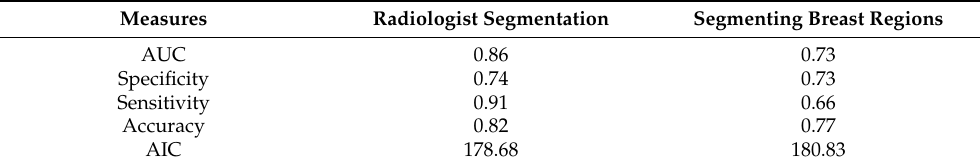
Table 5. Comparison between models with CS1 and CS2 calcifications.